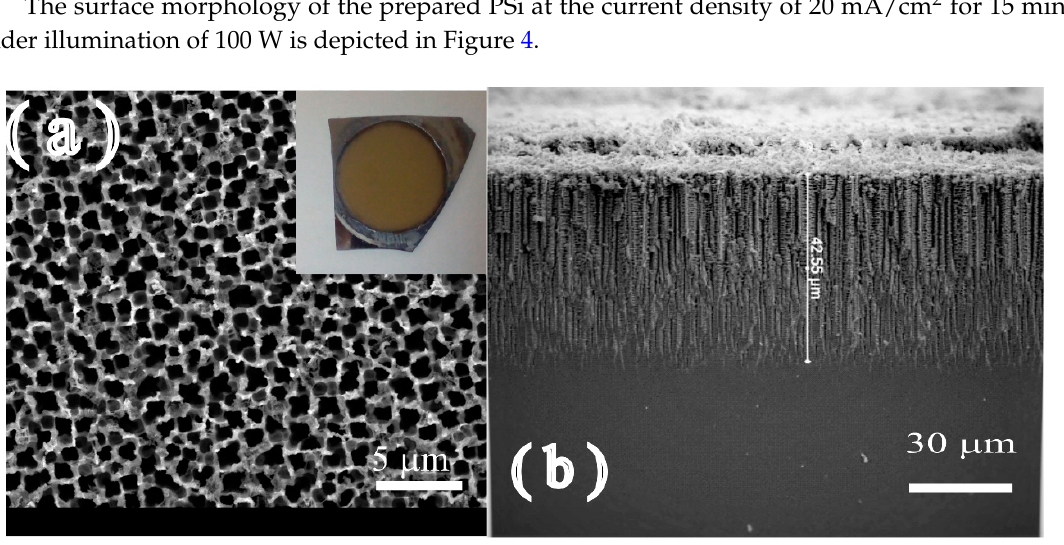
Figure 4. FE-SEM image of the surface: ( a ) inset depicts the optical image of the PSi surface and ( b ) cross section of the prepared PSi.